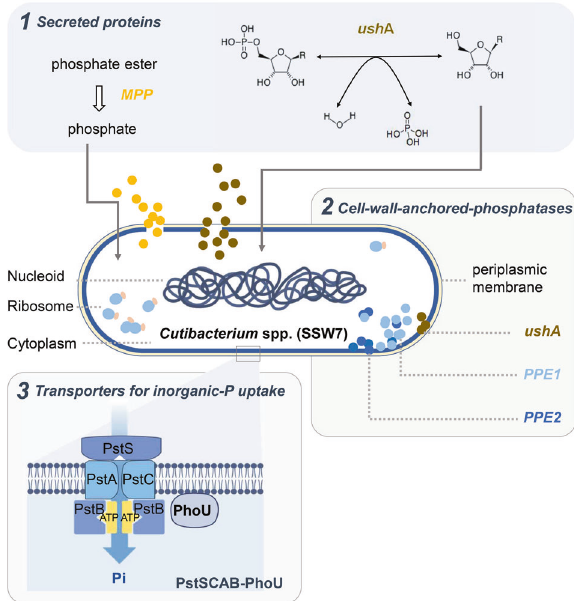
Fig. 7 Phosphorus dissolution mechanisms derived from the one- cell organic-PSM genome of SSW7 (annotated as Cutibacterium spp.). Two secreted phosphatases ( ushA and MPP ), three phospha- tases proteins ( ushA , PPE1 and PPE2 ), and the PstSCAB-PhoU gene cluster are key components that underpin the strong organic-P solubilizing phenotype of SSW7 and related strains in the